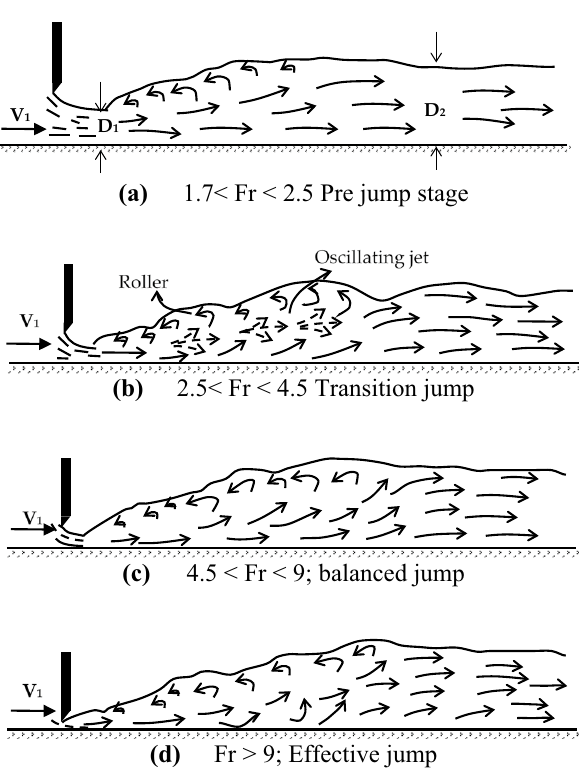
Fig. 3 Rating curve of the